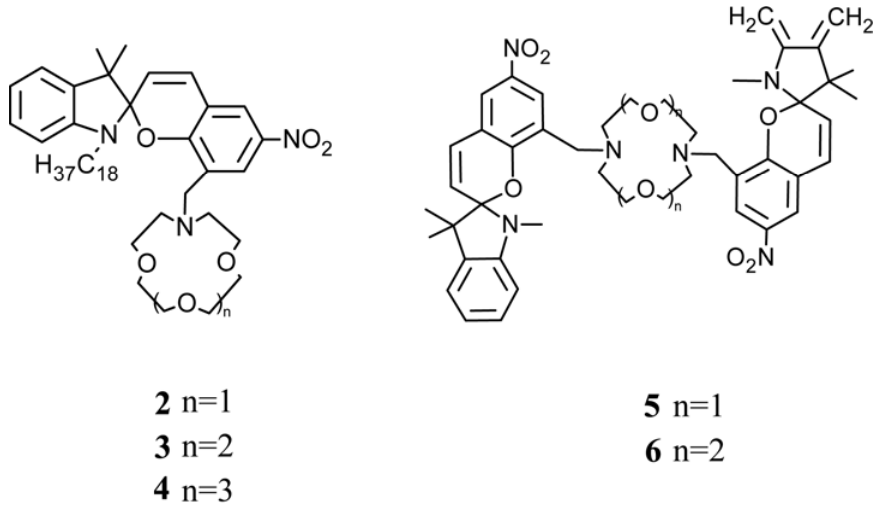
Figure 18. Chemical formula of photo-chromic crown